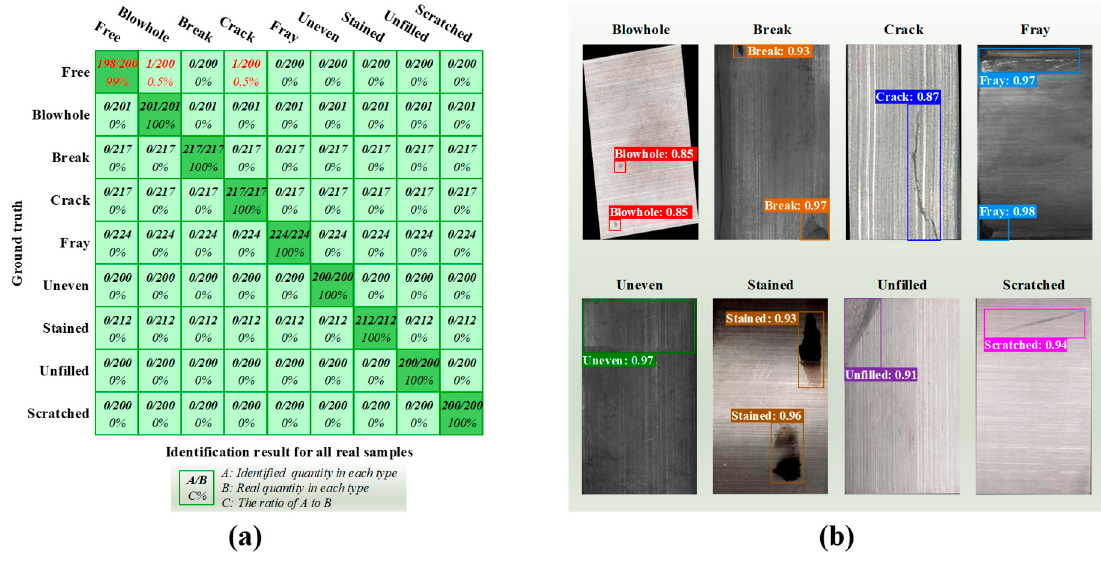
Figure 8. Identification results for the testing set: ( a ) confusion matrix of identification results; ( b ) visualization of identification results.